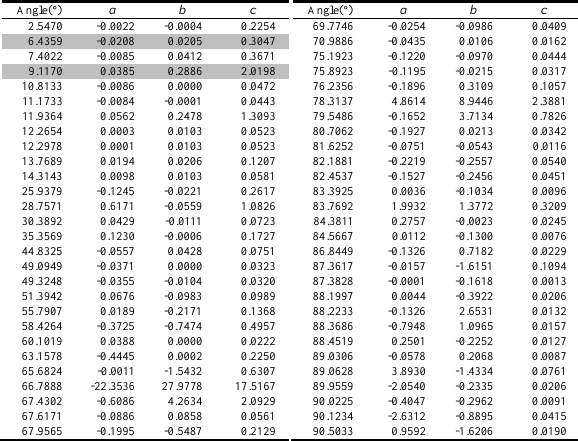
Table 2. Angle between eye vector and normal